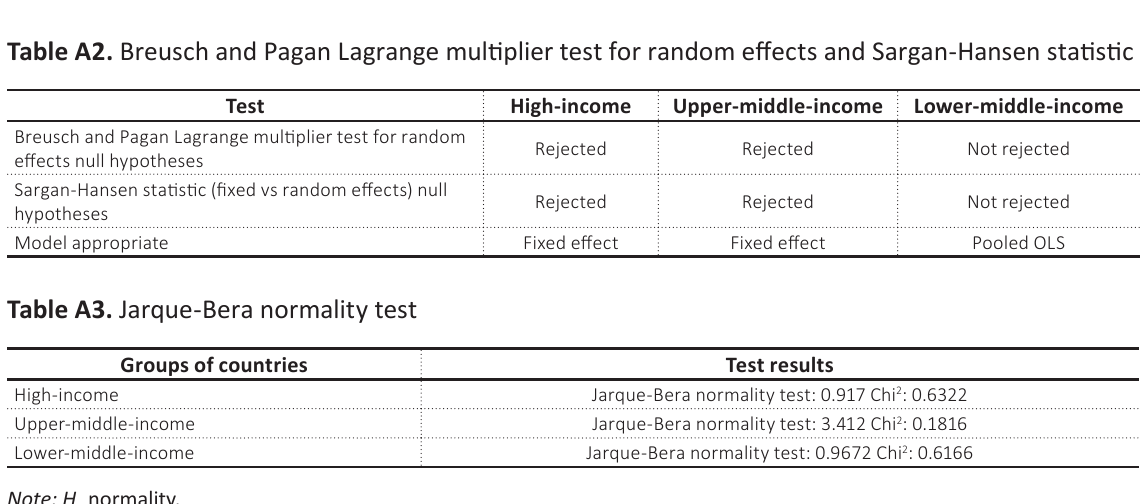
Table А4. Variance Inflation Factor (VIF) test for multicollinearity